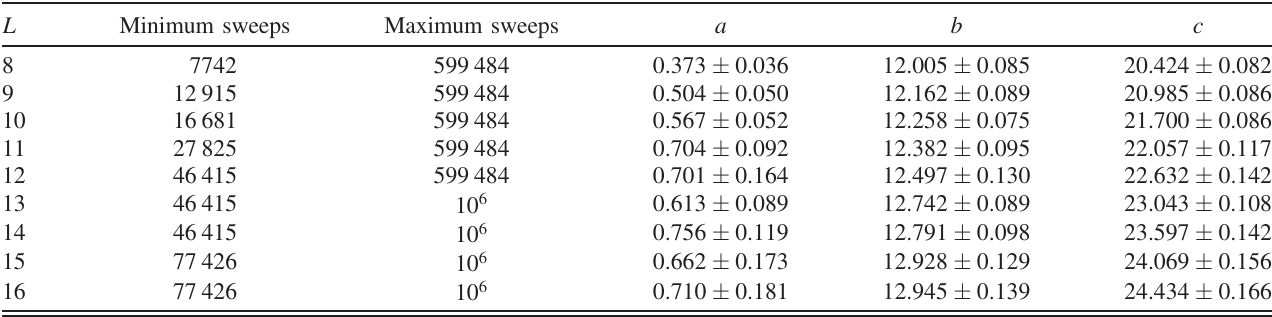
TABLE XIV. Fit to y ¼ a ð x − b Þ 2 þ c for the median results of the hardware-planted instances using SQA with y ¼ log TTS and x ¼ log n . The factor c does not include f sweeps